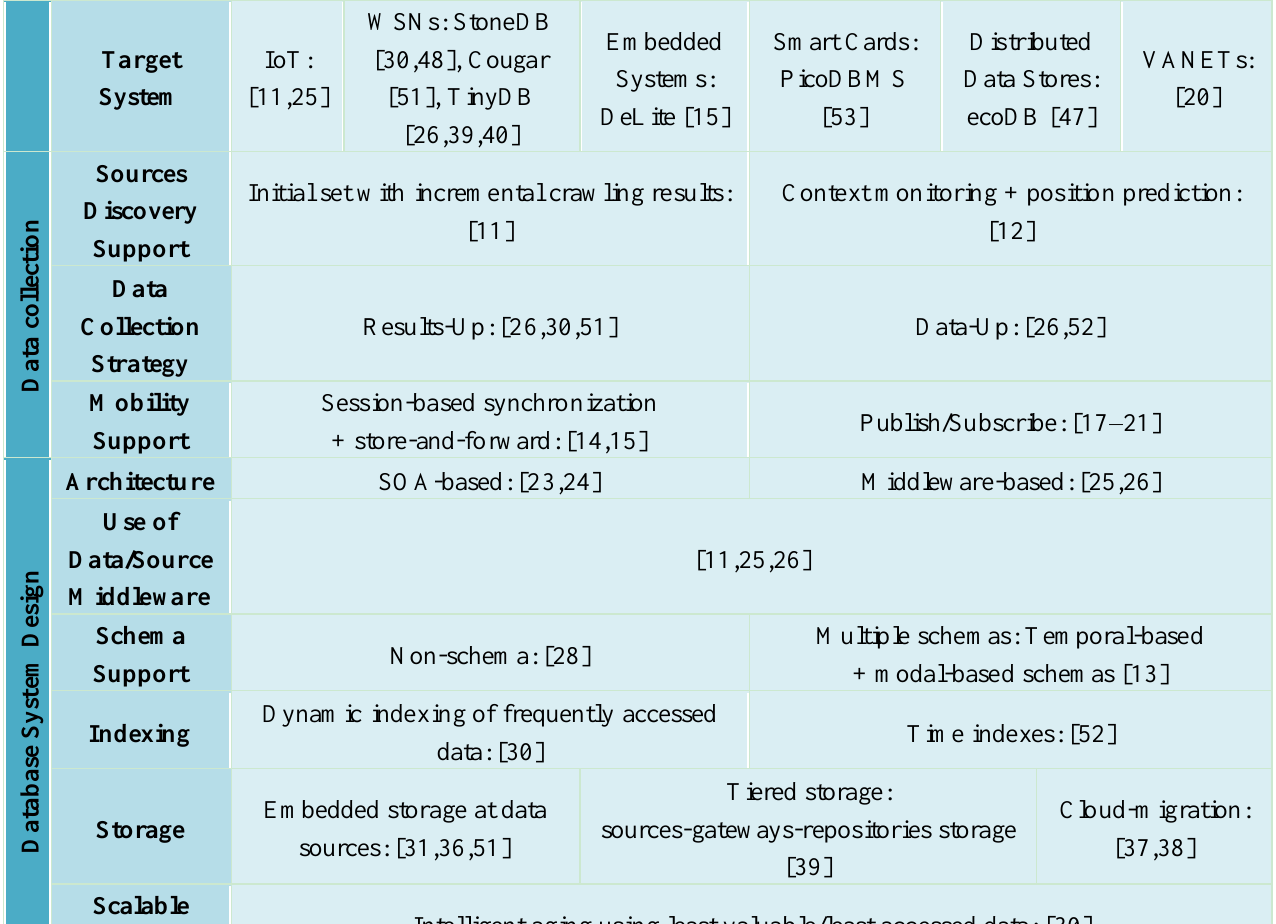
Table 1. IoT data management solutions addressing design